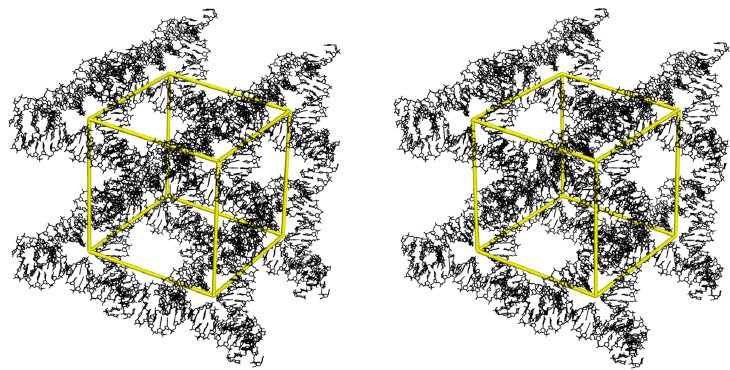
Figure 3. Tensegrity crystal solvent pockets. A stereoscopic view of eight tensegrity triangle motifs in the crystal lattice that generate a rhombohedral solvent space (yellow outline).